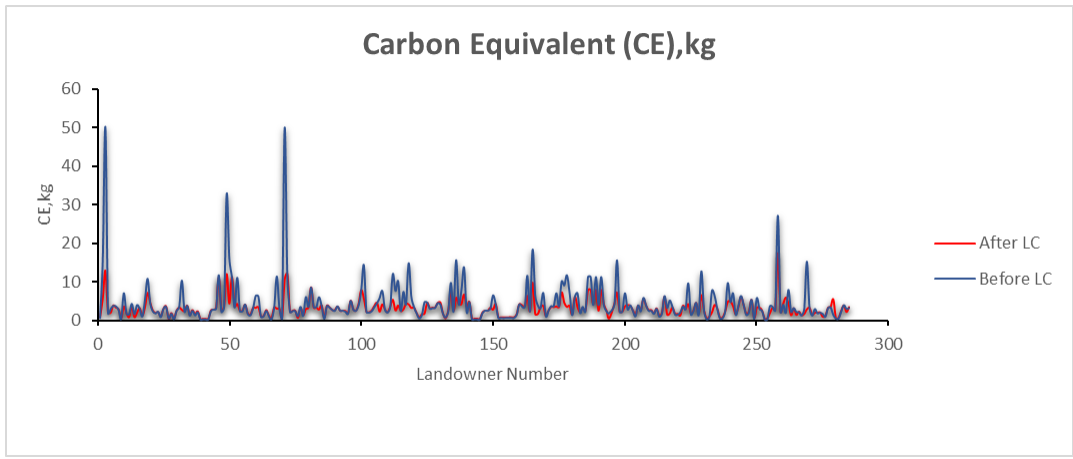
Figure 6. Changes in the carbon footprint values on individual farms as a result of land consolidation (Selimiye